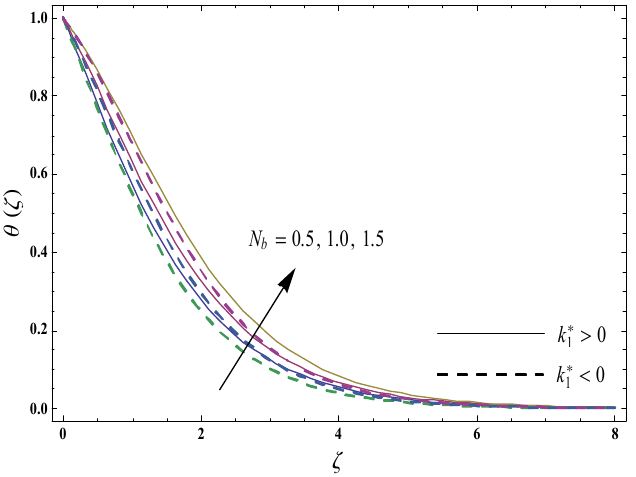
M = 0.2. and  = 0  2  Fig. 3 : Variations of temperature for Prandtl number when 